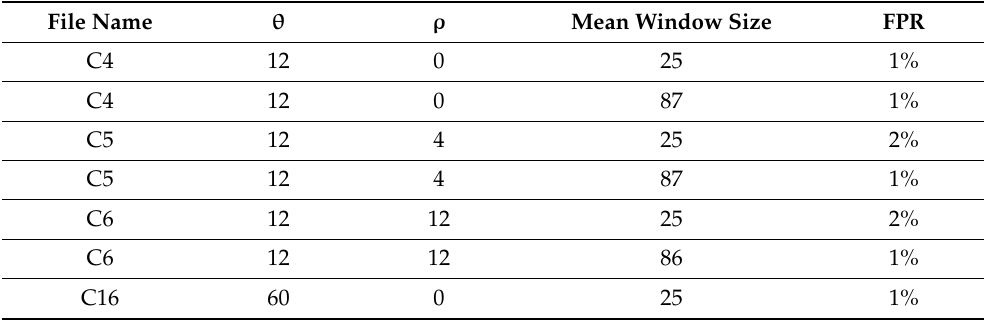
Table A1. False positive rate (FPR) for the divergent selection detection variance test using simulated neutral evolution data available from Carvajal-Rodr í guez, 2017 [21]. The genome size was 1 Mb. Population size N = 1000. Number of generations T = 10,000. Population mutation rate θ = 4 N µ . Population recombination rate ρ = 4 Nr . The candidate position is in the middle of the window. The total number of replicates for each case was 1000. FPR = 100 × number of replicates with significant test/1000. MAF = 1%. Significance level α =